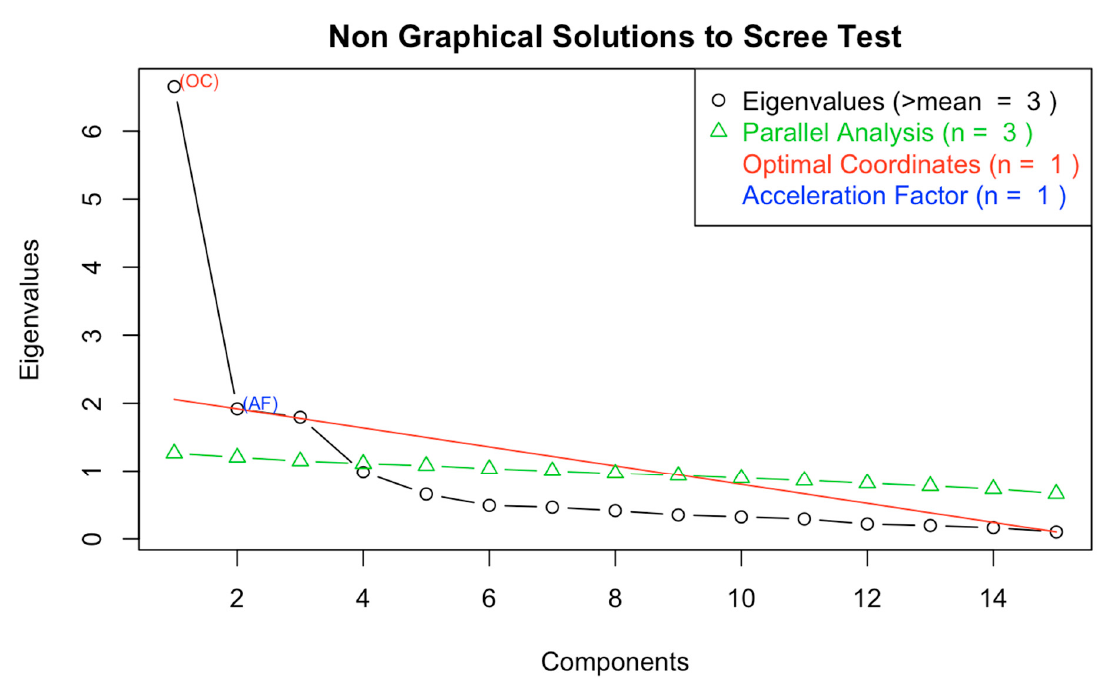
Figure 1. Possible solutions to the number of factors. Both the eigenvalues and parallel analyses suggest a three-factor solution. Table 1. Factor loadings for all dependent measures.